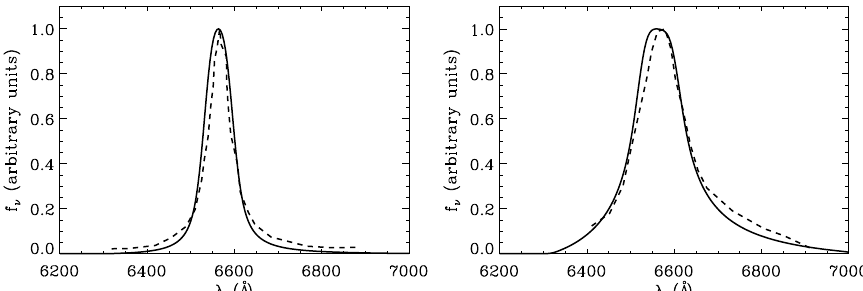
Fig. 3. The simulated (solid line) and observed (dashed line) H (cid:11) emission line profiles. The observed line profile is the average of profiles for populations A (left) and B (right), adapted from Sulentic et al. (2009). The simulated line profiles are not fitted to the observed line profiles, but were chosen to have realistic model parameter values. Only the radial density profile of the wind and the outer radius of the line-emitting region differ between the two simulated line